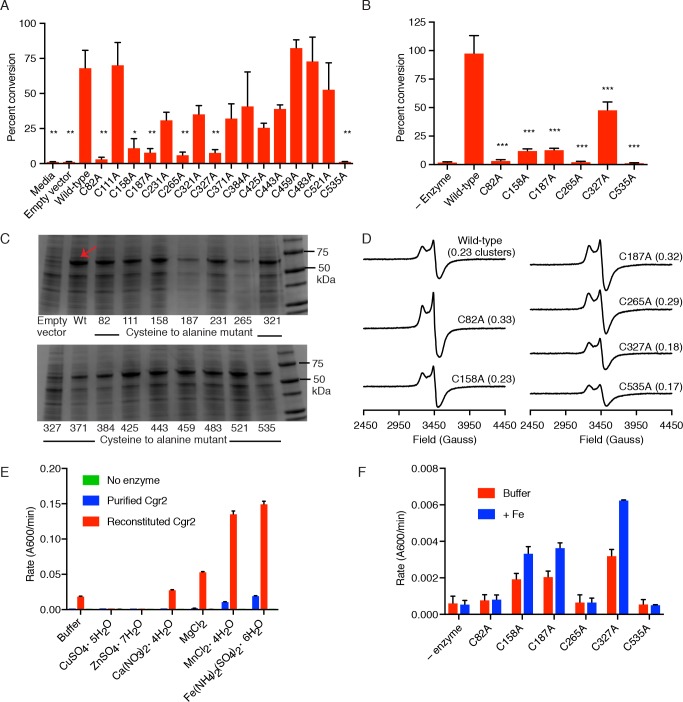
Identification of 6 cysteine residues important for Cgr2 activity.(A) Whole cell assays of R. erythropolis expressing individual cysteine to alanine point mutants and incubated with digoxin demonstrated that six cysteine residues are important for activity. Data represents mean ± SEM (n = 3 biological replicates). Asterisks indicate statistical significance of each variant compared to wild-type Cgr2 by Student’s t test (*p<0.05, **p<0.01) (Figure 2—source data 4). (B) Mass spectrometry analysis of in vitro assays (quenched at 15 min) containing reconstituted wild-type Cgr2 or single cysteine to alanine point mutants. Data represents mean ± SEM (n = 3 independent experiments). Asterisks indicate statistical significance of each variant compared to wild-type Cgr2 by Student’s t test (***p<0.001) (Figure 2—source data 5). (C) SDS-PAGE analysis of clarified lysate from R. erythropolis cells transformed with empty pTipQC vector or expressing cytoplasmic wild-type Cgr2 (wt) or individual cysteine to alanine point mutants (~55 kDa). All point mutants were soluble. (D) [4Fe-4S]1+ clusters were detected by EPR in all Cgr2 point mutants treated with sodium dithionite. Spin quantitation against a Cu2+-EDTA standard revealed similar levels of [4Fe-4S]1+ clusters per Cgr2 monomer for all variants. Number of clusters shown in parentheses. (E) Divalent metal cations (Fe2+, Mg2+, Mn2+) stimulated the activity of Cgr2 in vitro. Data represents mean ± SEM (n = 3 independent experiments). (F) Addition of Fe2+ stimulated the activity of three cysteine residues, potentially implicating C92, C265, and C535 in metal binding. Data represents mean ± SEM (n = 3 independent experiments).